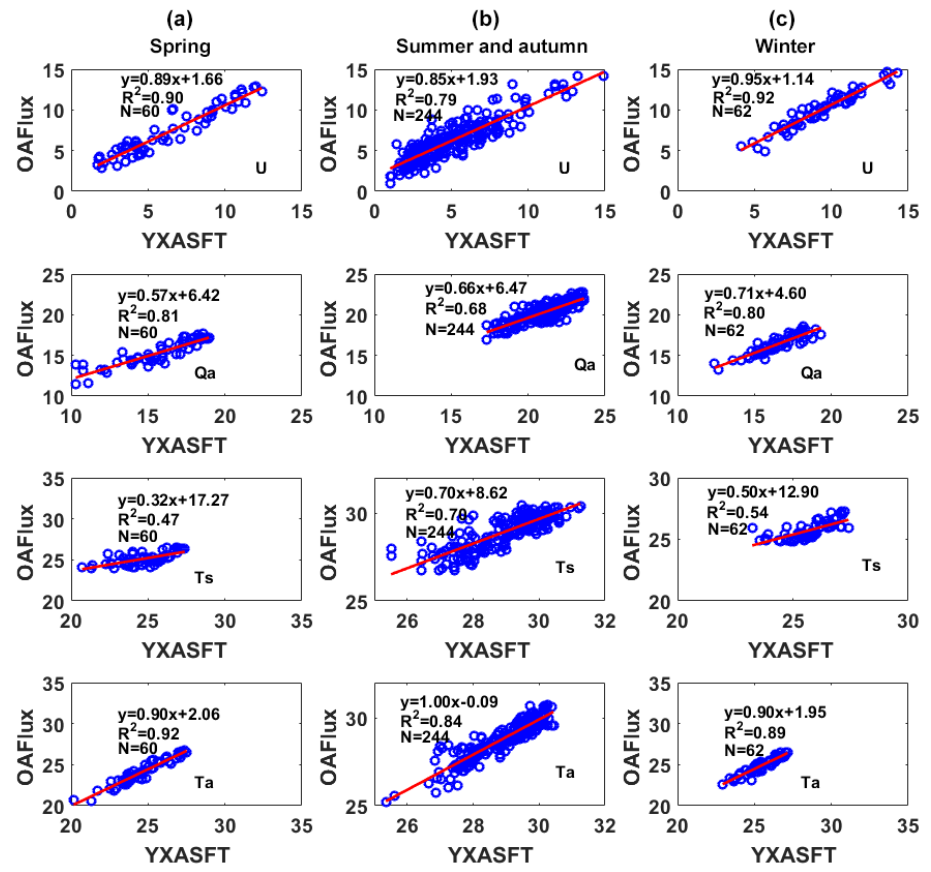
Figure 7. Scatter plots of the YXASFT and OAFlux wind speeds at 10m ( U ), air specific humidity at 2m ( Q a ), and sea surface temperatures ( T s ) and air temperatures at 2m ( T a ) during the spring (a) , summer–autumn (b) and winter (c) periods. The units for U , Q a , T s and T a are ms − 1 , gkg − 1 , ◦ C and ◦ C, respectively. The linear regression equation, coefficient of determination ( R 2 ) and number of matched pairs ( N ) are given in each panel. The solid red line refers to the linear regression of the matched